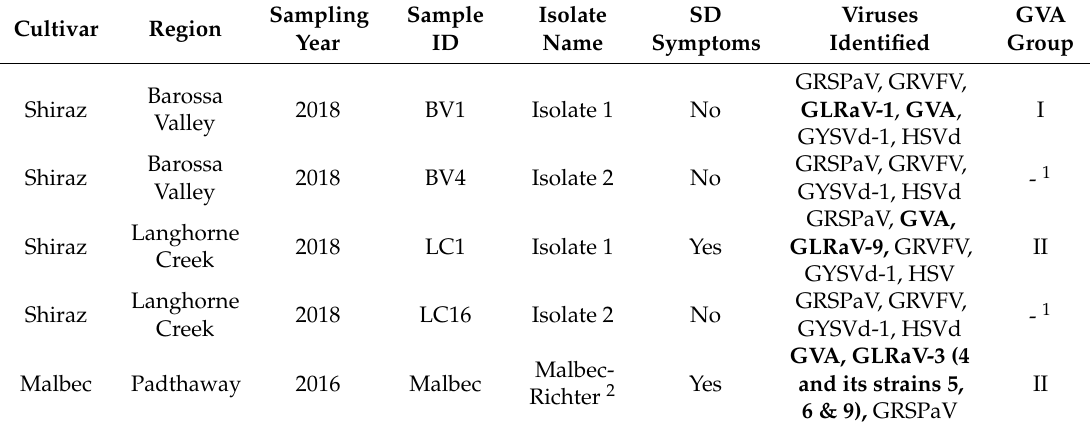
Table4. VirusprofilesinShirazDisease(SD)-a ff ectedandnon-SD-a ff ectedShirazandMalbecgrapevines from South Australia. The potential viral agents of SD are highlighted in bold.